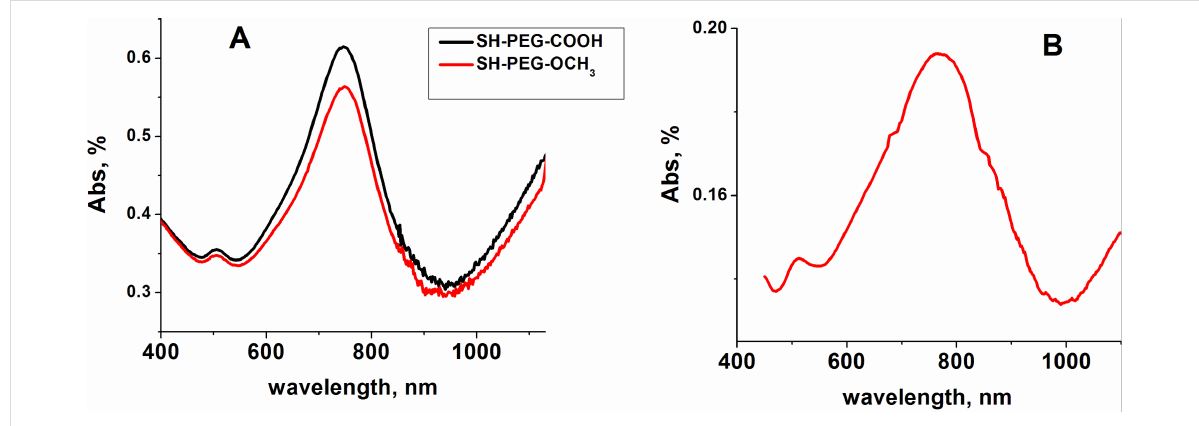
Figure 1: Extinction spectra of aqueous solutions of PEGylated GNSs (A) and the PVA-GNS film (B).